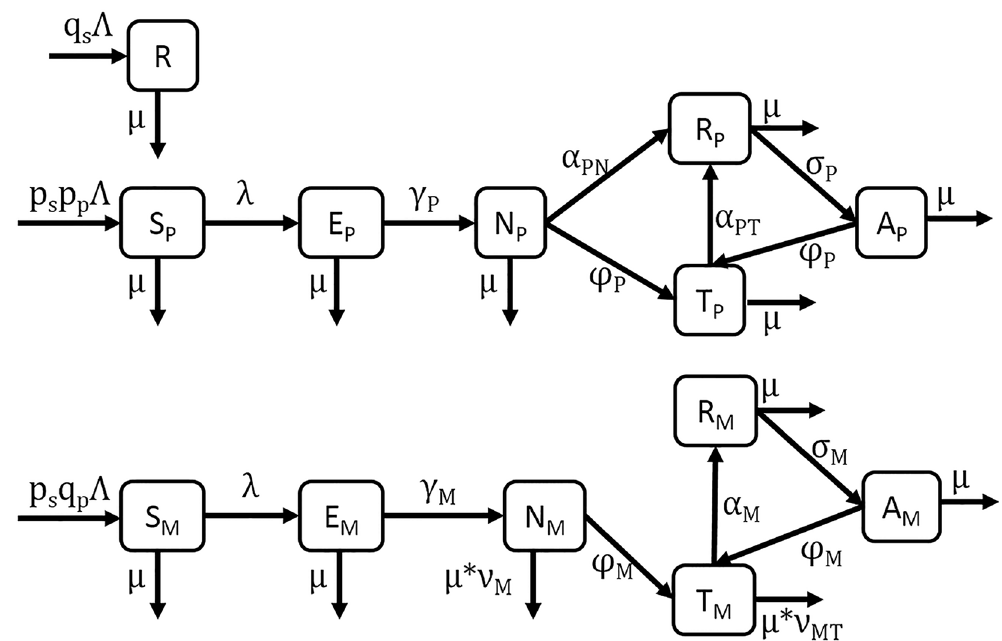
Fig 1. A compartment model of Hansen ’ s